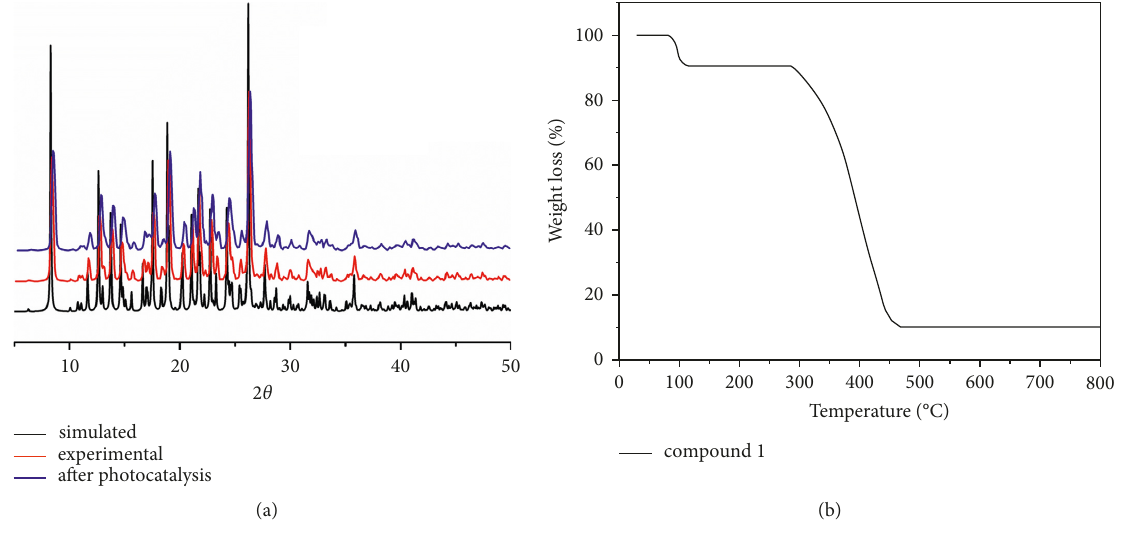
Figure 2: (a) The compound’s patterns of PXRD and (b) its TGA